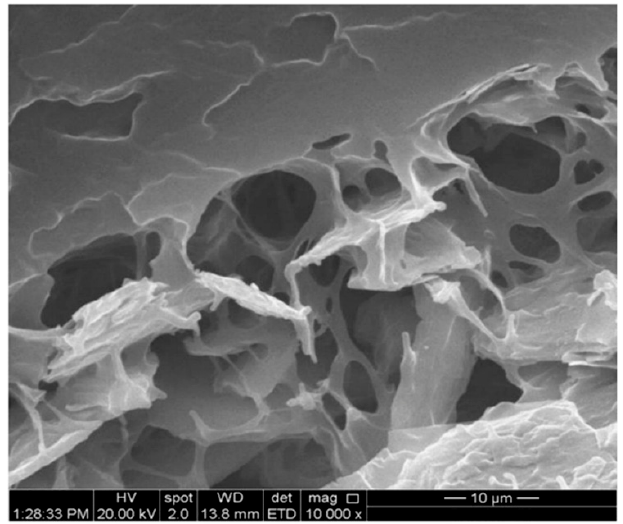
Figure 9. SEM micrograph of internal pores of PDVL/TiO 2 -1 hybrid material containing interconnected pores.